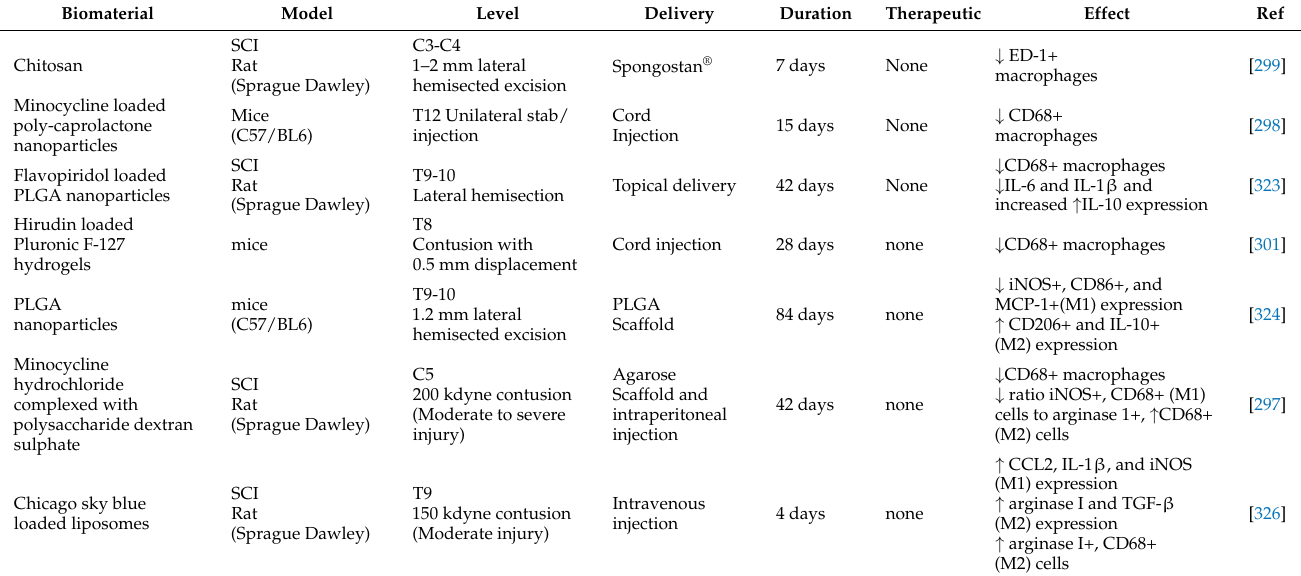
Table 6. Nanoparticle formulation methods for modifying macrophage polarization in central nerve injury. Where ↑ indicates an increase in specific cells population and ↓ indicates a decrease in specific cell